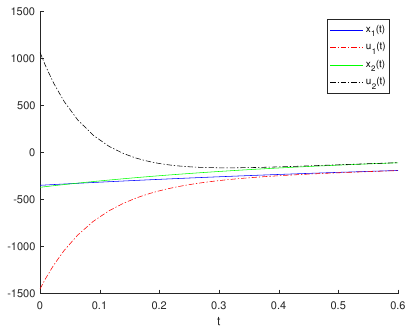
Figure 4. The curves of x 1 ( t ) , x 2 ( t ) , u 1 ( t ) , u 2 ( t ) from Example